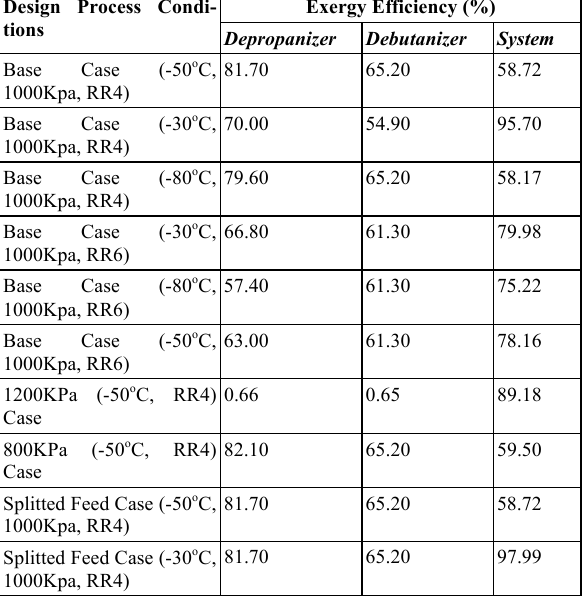
TABLE II. COLUMNS AND SYSTEMS IRREVERSIBILITY FOR